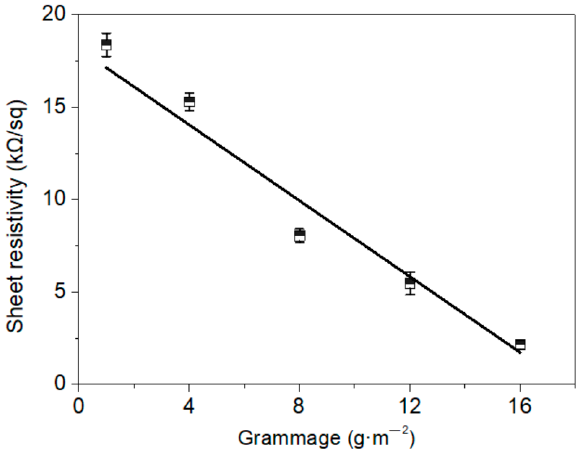
Figure 9. Sheet resistivity of the 50 wt.% graphene membranes with different grammages.